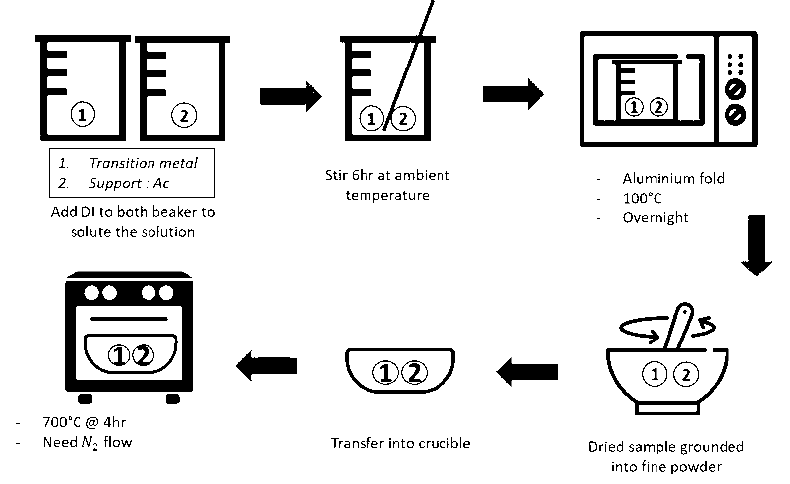
Figure 1. Schematic diagram for catalyst synthesis by wet impregnation method.